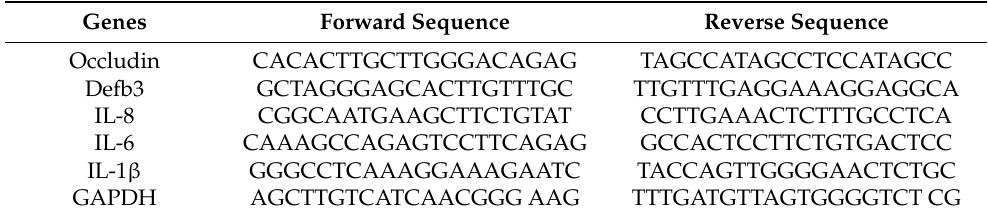
Table 1. Primers sequences used for real-time